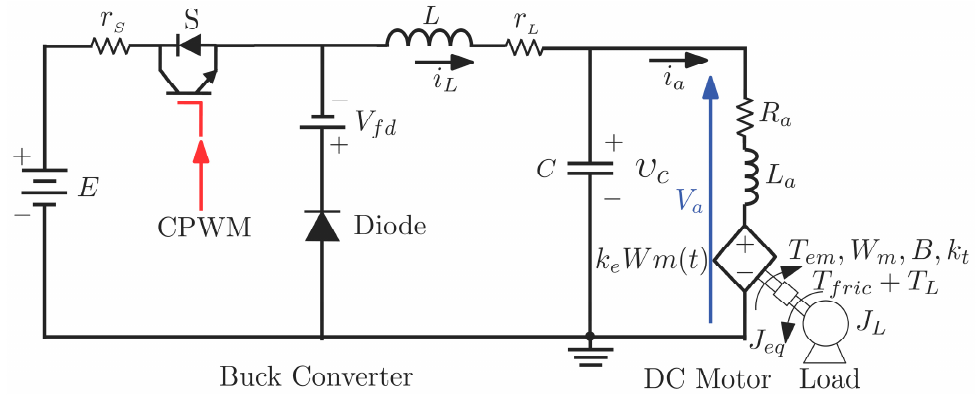
Figure 2. Electromechanical system for speed control of a DC motor powered by a buck converter.